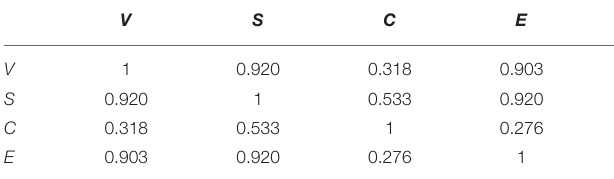
TABLE 7 | Regression results for soil depth as soil